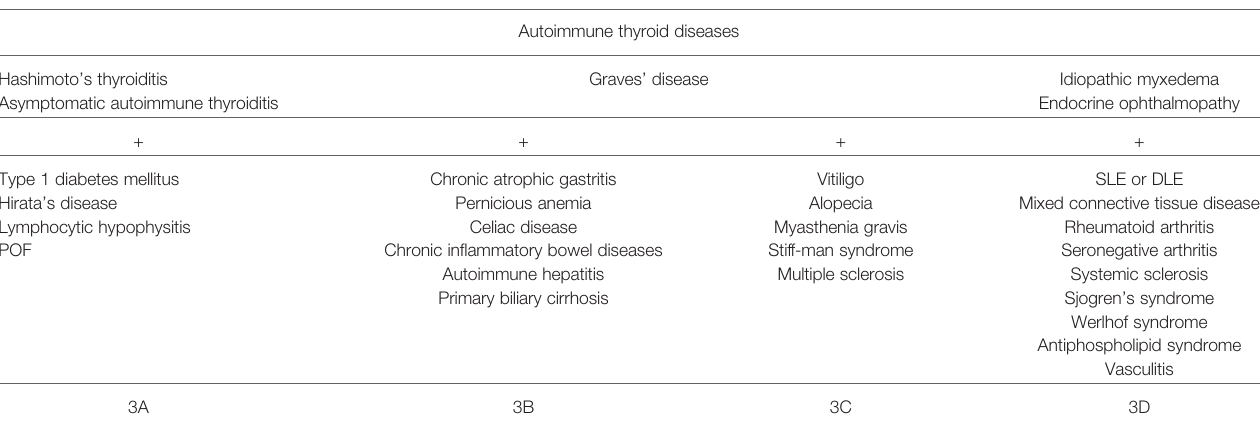
TABLE 4 | Characteristics of autoimmune polyglandular syndrome (APS) type 3 (2,